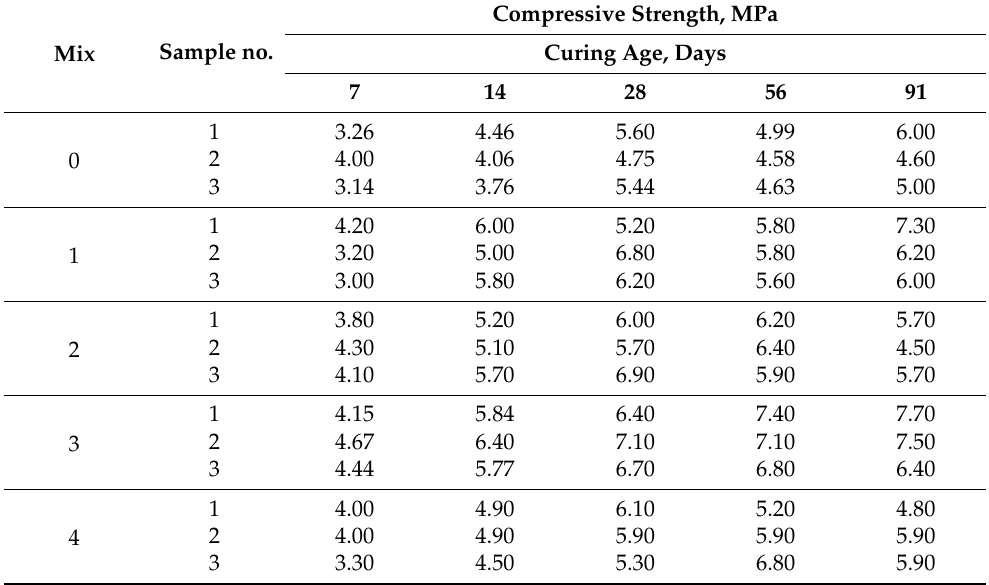
Table 8. Results of compressive strength measurement for the different considered pozzolanic- concrete mixtures at different curing ages.